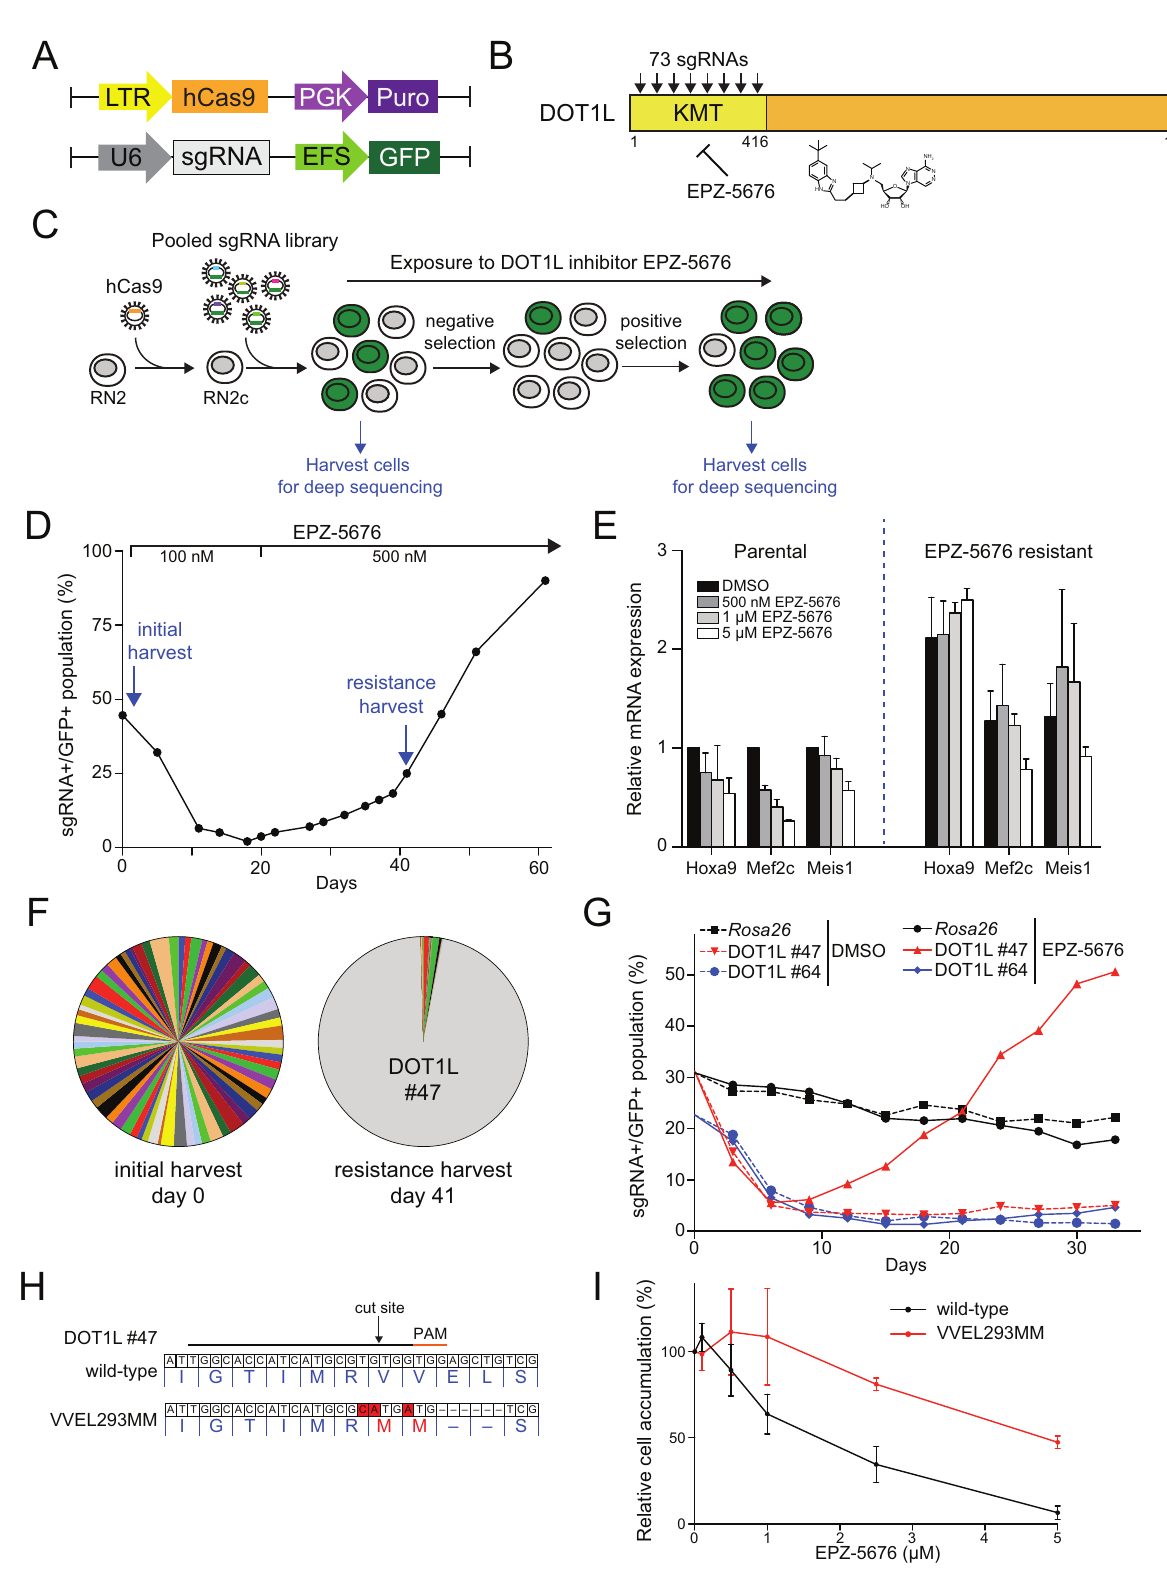
Fig 1. KMT domain-focused CRISPR indel mutagenesis revealsa DOT1L allele that confers resistance to EPZ-5676 mediated growth arrest. ( A ) Schematic of the vector usedto deriveclonalMLL-AF9;Nras G12D leukemiaRN2c cellsthat expressa humancodon- optimized S . pyogenes Cas9(hCas9)andthe vectors usedfor lentiviralsgRNA transduction. A GFP reporterwas